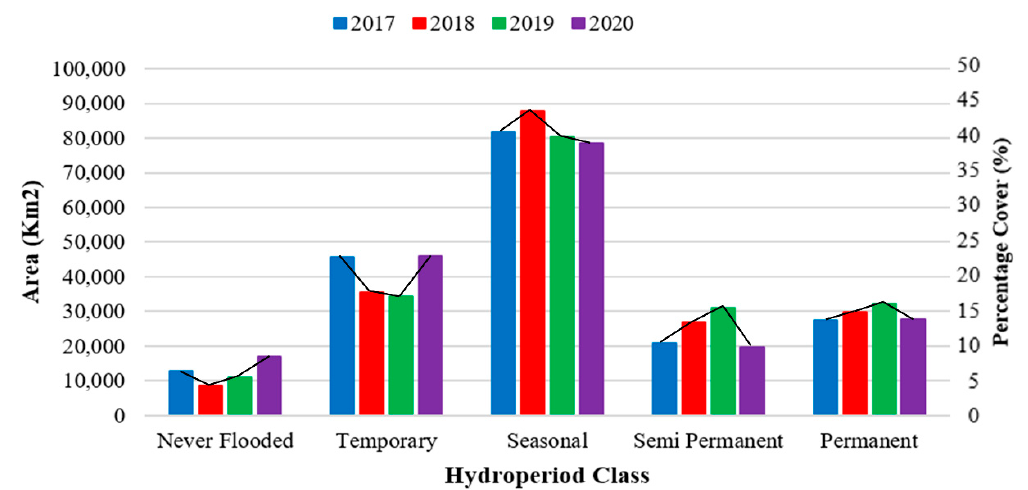
Figure 9. Area and percentage cover of each hydroperiod class in different years.